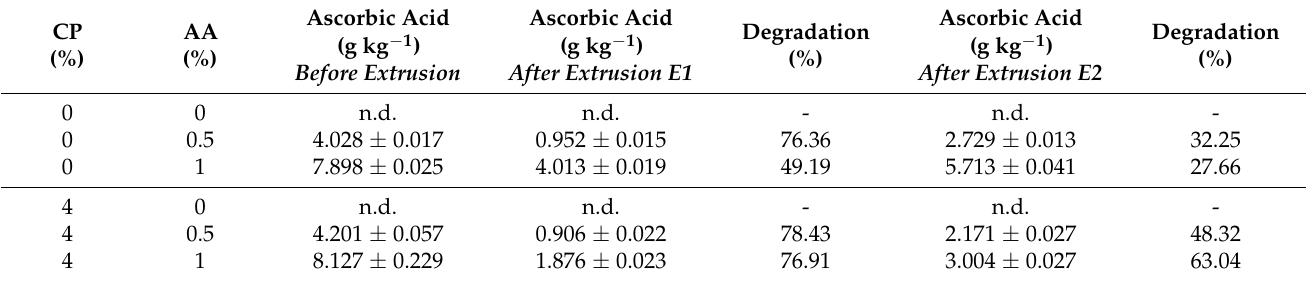
Table 1. Ascorbic acid content before and after extrusion in raw and extruded samples A